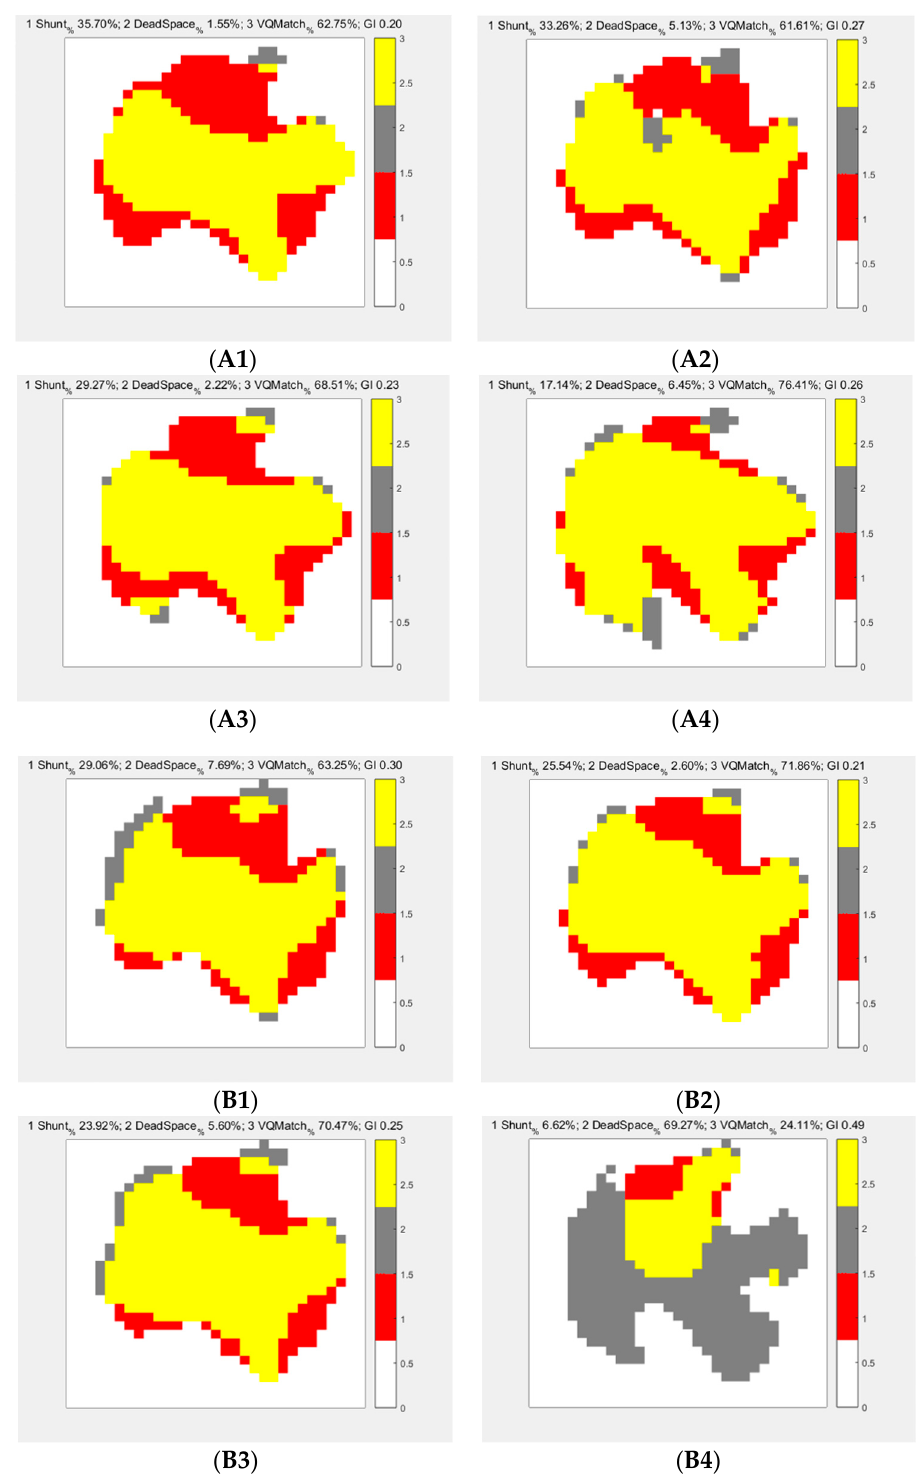
Figure 3. EIT images under high and low cardiac output (CO) and different PEEPs. ( A ) High flow intervention (high CO), and ( B ) low flow intervention (low CO). The PEEP changes are shown from left to right at 0, 5, 10, and 20 cmH 2 O. At high cardiac output, the shunt was large and improved with increased PEEP. At low cardiac output, the shunt showed limited improvement, and the dead space increased with increasing PEEP. The high cardiac output V/Q ratio improved obviously with increasing PEEP. Table 2. Changes in lung shunt, dead space, and ventilation/perfusion (V/Q) ratio under the influ- ence of high/low cardiac output and different PEEPs.